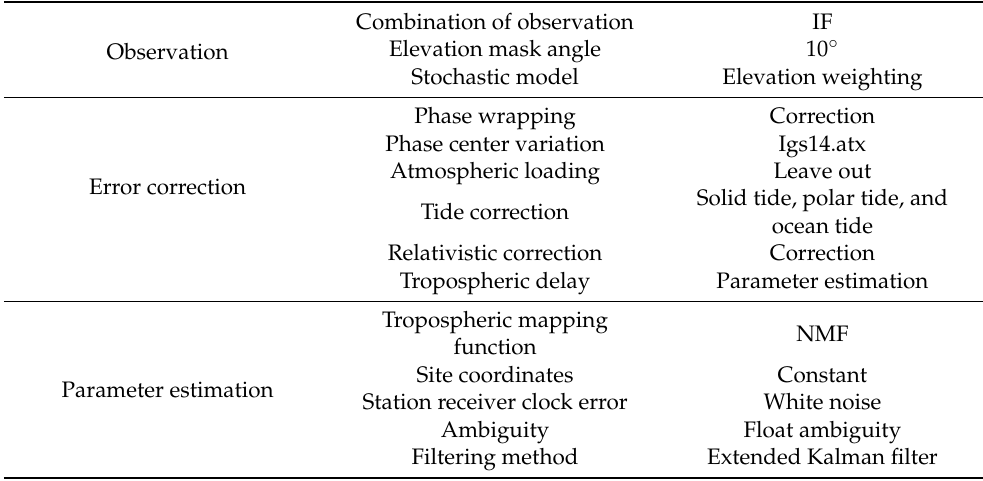
Table 2. PPP algorithm processing